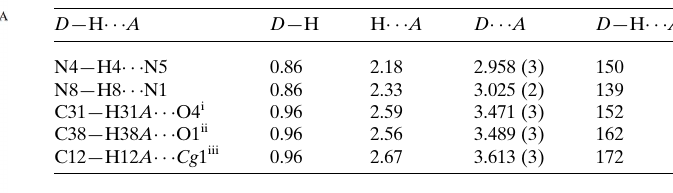
Table 1 Hydrogen-bond geometry (A˚ , (cid:2) ).